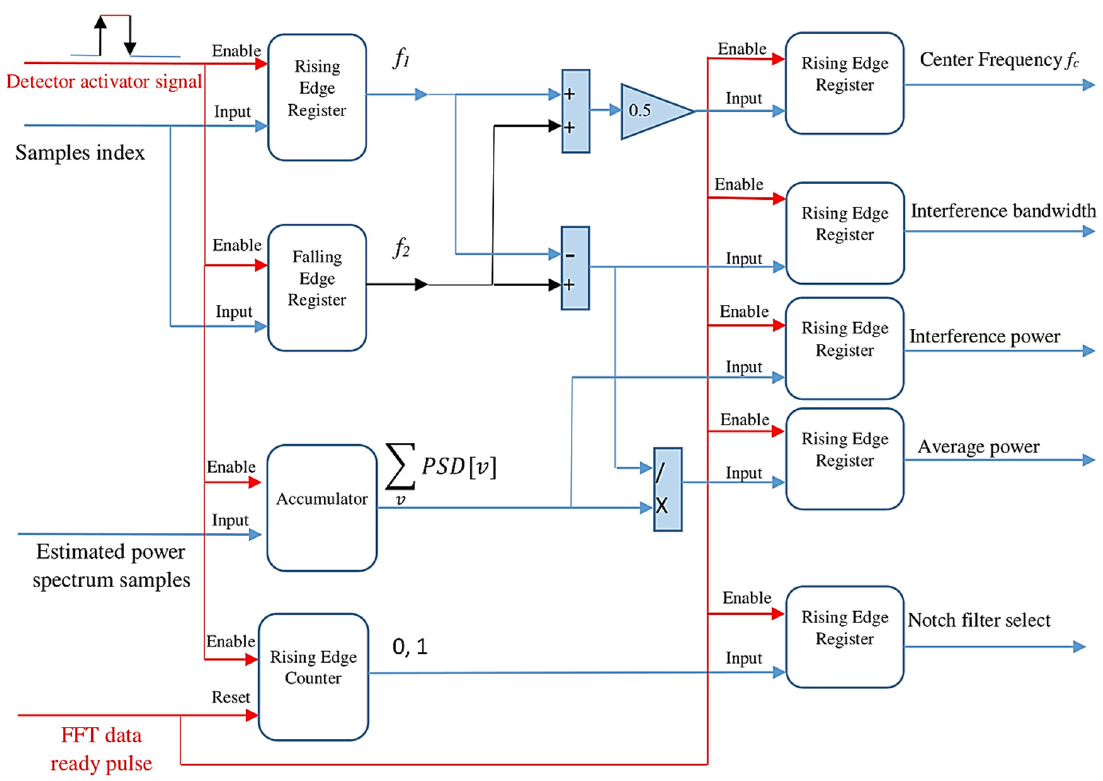
Figure 7. Utilized mechanism for extracting key parameters of interferences.